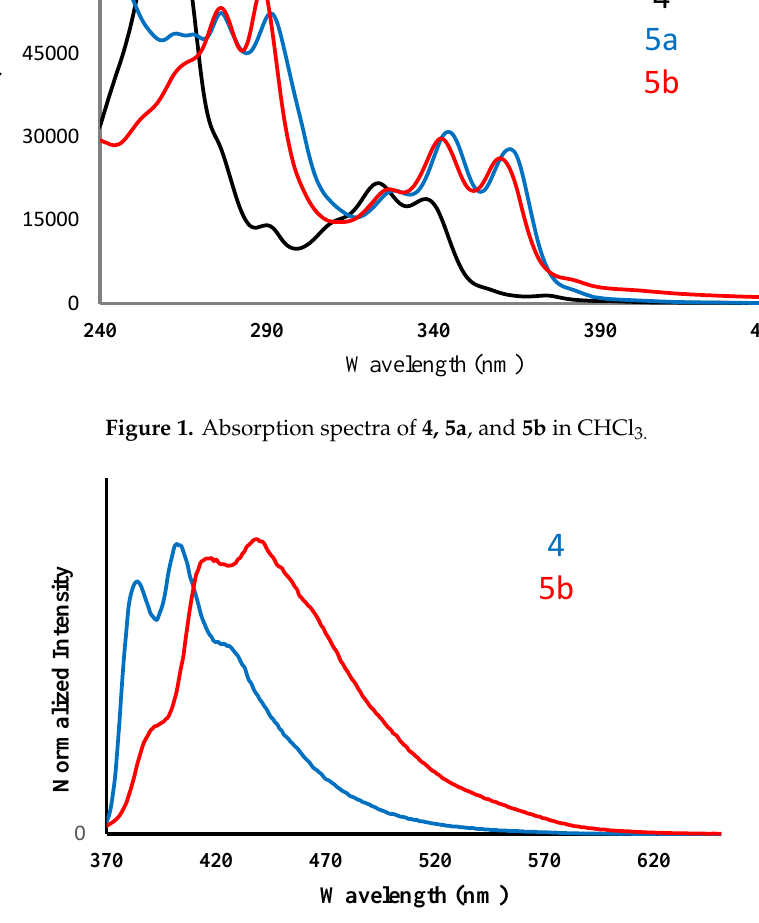
Figure 2. Overlaid normalized emission spectra of 4 and 5b.